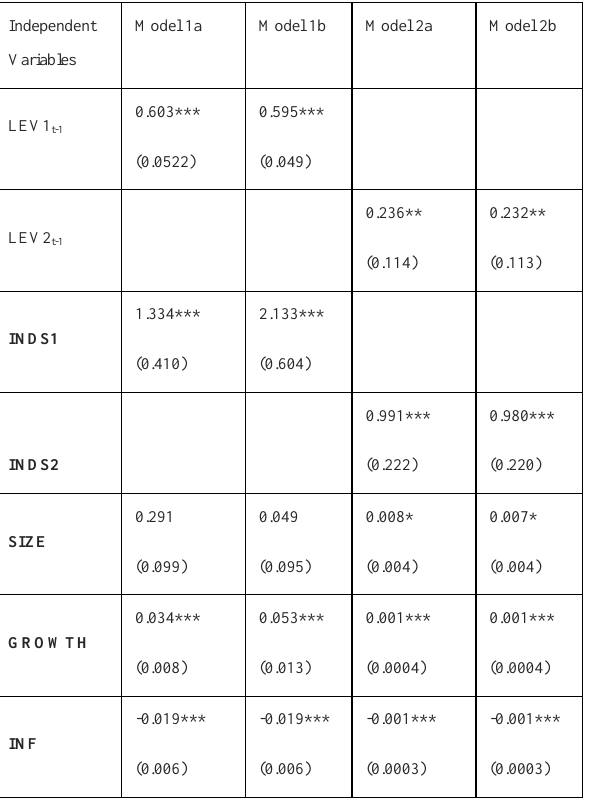
Table 3: Empirical results from estimations of target leverage the